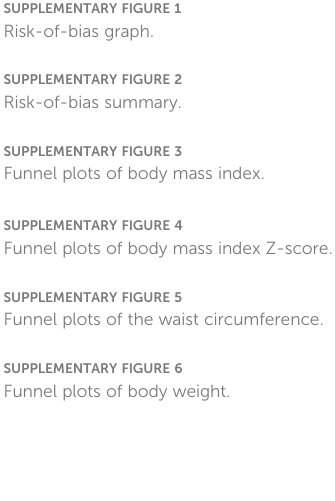
SUPPLEMENTARY FIGURE 1 Risk-of-bias graph. SUPPLEMENTARY FIGURE 2 Risk-of-bias summary. SUPPLEMENTARY FIGURE 3 Funnel plots of body mass index.